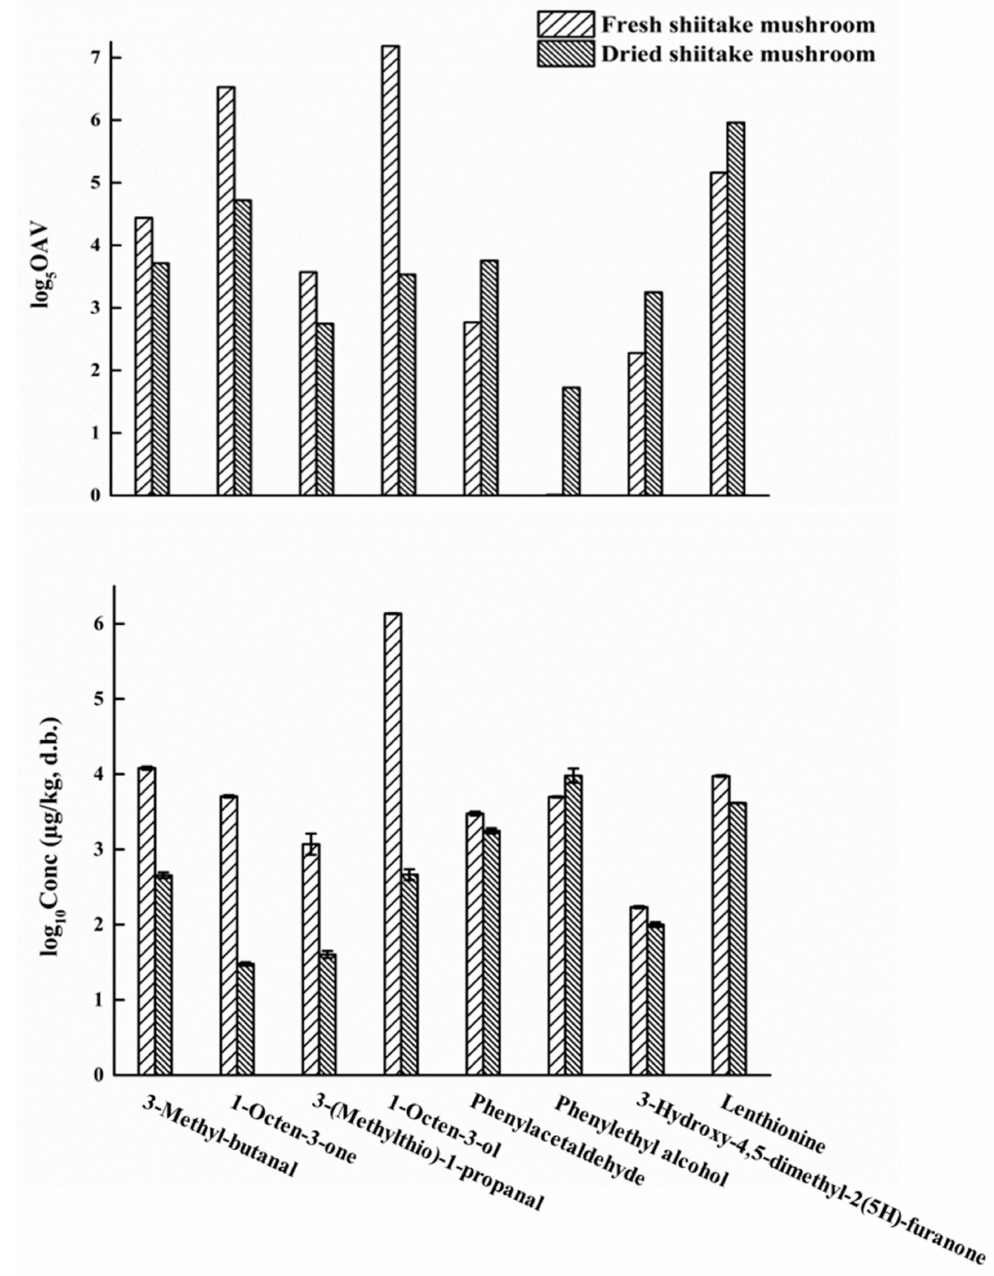
Figure 4. Odor activity values (log 5 OAV) and concentrations on a dry basis (log 10 Conc ( µ g/kg, d.b.)) of the key contributing odorants (OAV ≥ 1) in both fresh and dried shiitake